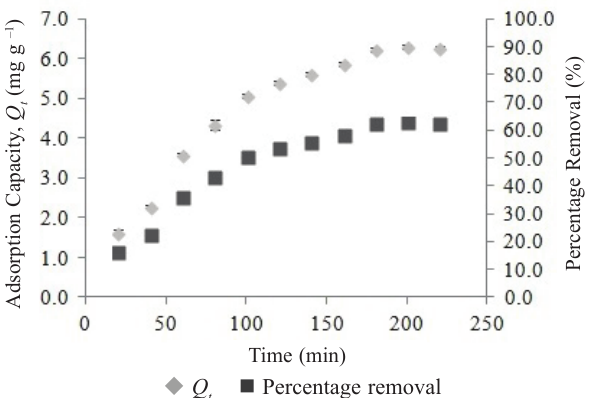
Fig. 5 – Adsorption rate curve of Reactive Red 141 (initial dye concentration = 200 mg L –1 ; adsorbent dosage = 1.0 g/50 mL; pH = 6)